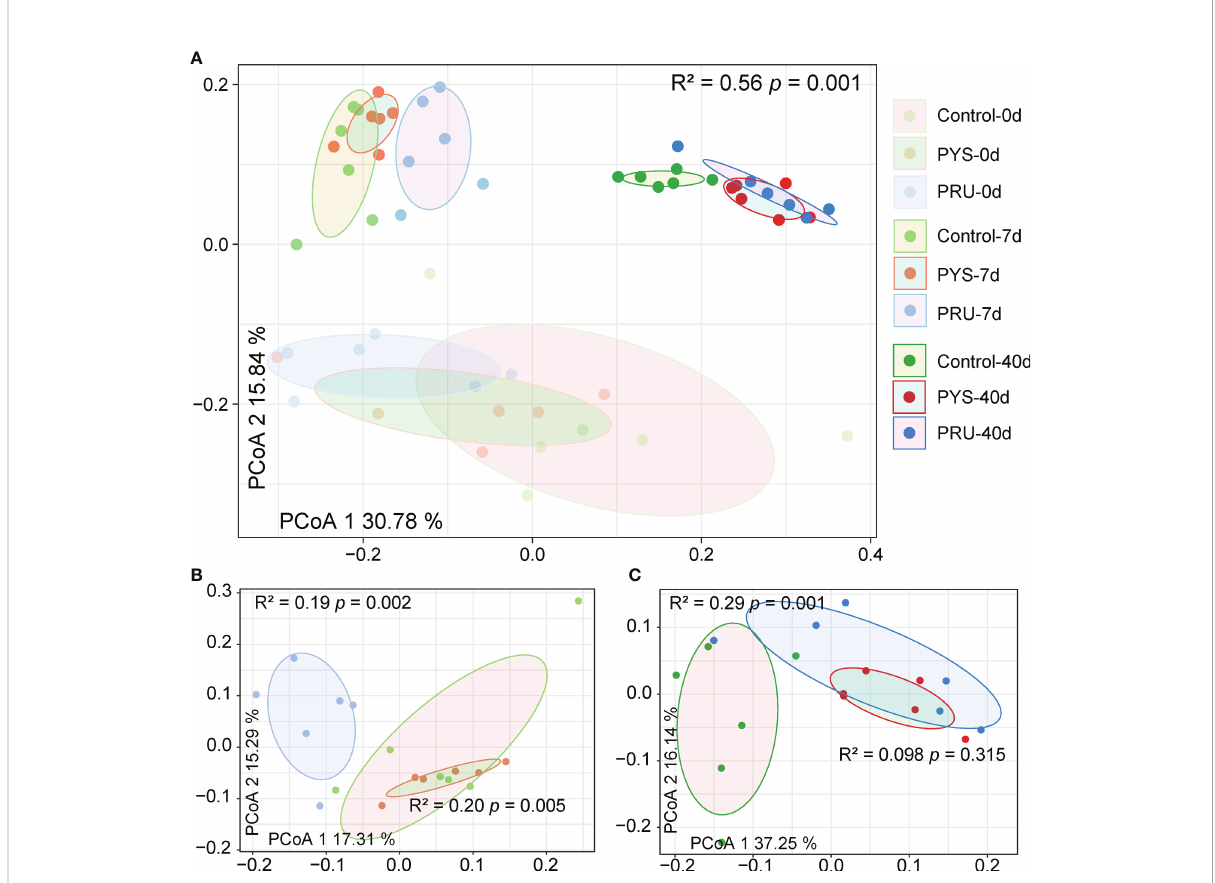
FIGURE 2 Differences in gut microbiota structure between groups. (A) PCoA analysis based on the Bray-Curtis distance of ASVs reveals the separation between different groups. The position of sample (represented by nodes) in the fi rst two principal coordinates is shown below. (B) and (C) Differences between groups on day 7 and 40 post infection, respectively. R 2 and p values represent the results of